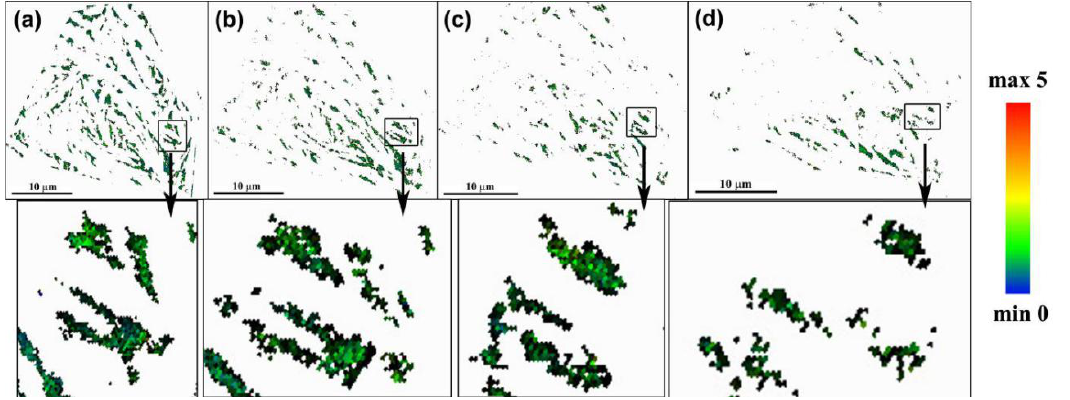
Figure 8. Distribution of kernel average misorientation (KAM) for RA at different strains: ( a ) 0, ( b ) 0.025, ( c ) 0.054, and ( d ) 0.104.